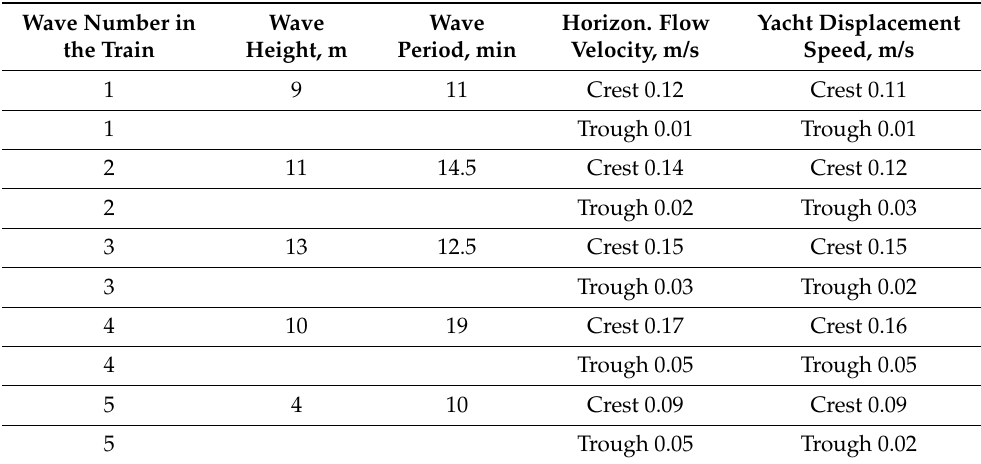
Table 1. Parameters of internal waves and the flow velocity and yacht displacement speed caused by each wave of the train. Wave Number in Wave Wave Horizon. Flow Yacht Displacement the Train Height, m Period, min Velocity, m/s Speed, m/s Trough